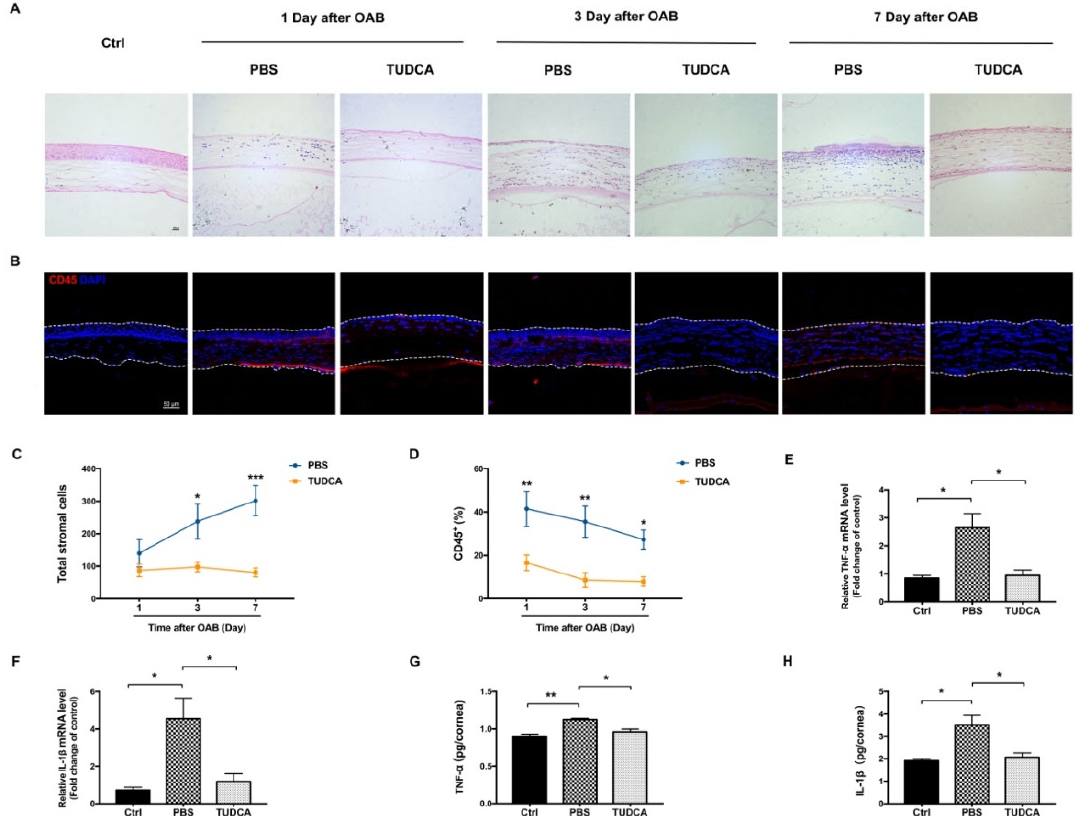
Figure 2. TUDCA suppresses corneal inflammation after OAB. ( A ) H&E staining of corneas in the control group, PBS-treated group, and TUDCA-treated group at 1, 3, and 7 days after OAB. Scale bar: 20 µ m. ( B ) Immunofluorescence staining with the leukocyte marker CD45 in the different groups. Scale bar: 50 µ m. ( C ) Quantitative analysis of corneal stromal cells in alkali injury eyes treated with PBS or TUDCA at different times ( n = 6 mice/group). ( D ) The quantification of CD45 + cells labeling is calculated as the total number of red cells (CD45 + cells) divided by the total number of blue cells (DAPI) in the corneal stroma, and then multiplied by 100 ( n = 6 mice/group). ( E , F ) RT-PCR analysis of the inflammatory cytokines TNF- α and IL-1 β in corneas collected 7 days after OAB. ( G , H ) Protein levels of TNF- α and IL-1 β were analyzed by ELISA. Data are expressed as mean ± SEM ( n = 3, * p < 0.05, ** p < 0.01, *** p < 0.001). Ctrl, control; OAB, ocular alkali burn; TUDCA, tauroursodeoxycholic